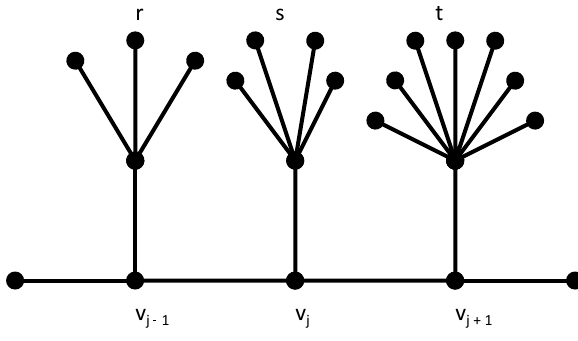
Figure 19: Configurations at 𝑣